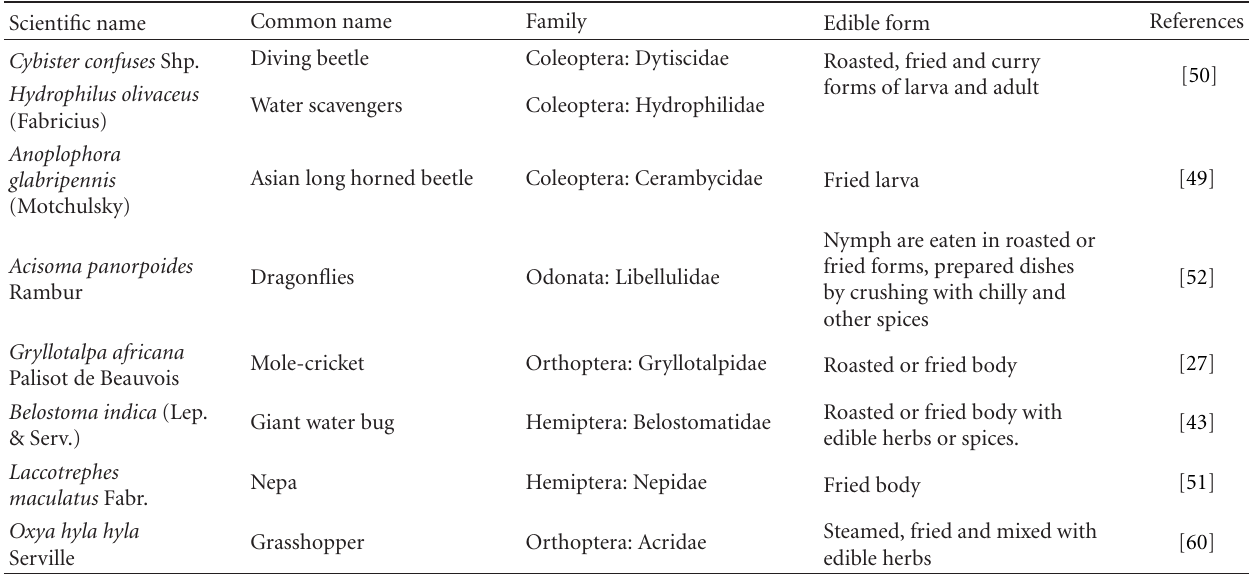
Table 3: Common edible insects in India.